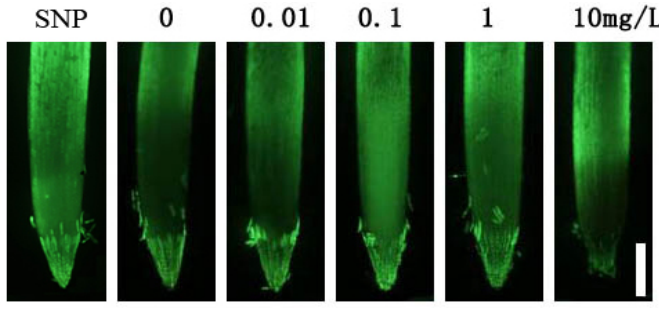
Figure 4. Visualization of nitric oxide generation in primary wheat roots in vivo . Seeds were soaked with sodium nitroprusside (SNP; 100 μ mol/L) or Fe-chlorophyllin at 0, 0.01, 0.1, 1 and 10 mg/L for 12 h and then transferred to the quarter-strength Hoagland’s nutrient solution containing different concentrations of Fe-chlorophyllin for four days after germination. The seedling roots were loaded with 15 μ M 4,5-diaminofluorescence (DAF-2DA) for 15 min and immediately photographed (bar = 0.5 mm).